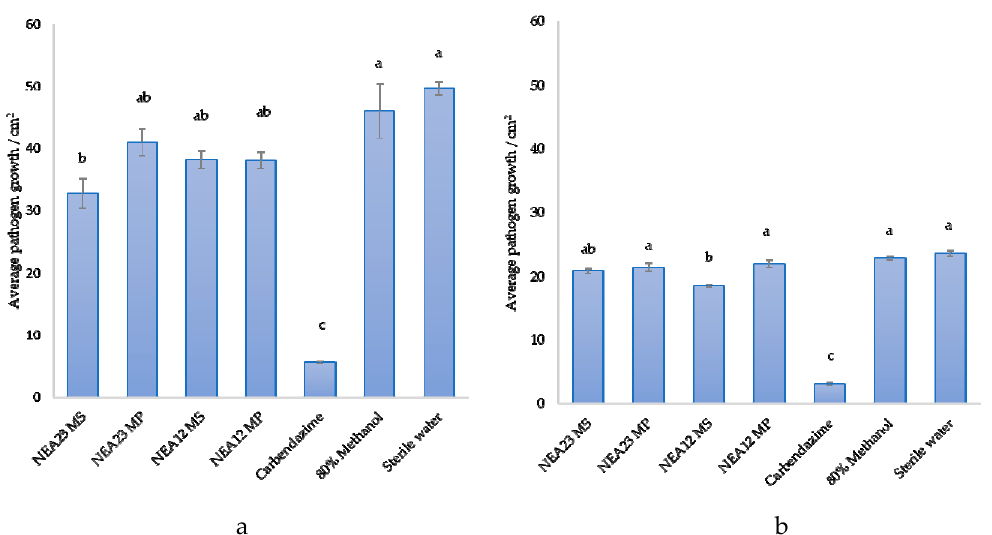
Figure 4. Pathogen growth inhibition by crude extracts from Epichloë spp. endophyte strains NEA12 and NEA23. From left to right: NEA23 MS, NEA23 MP, NEA12 MS, NEA12 MP, carbendazime (1 mg/mL), 80% methanol, and water against ( a ) Ceratobasidium sp; ( b ) Fusarium sp. Image analysis measured growth area (cm 2 ) of the pathogen in the agar well diffusion assay. All data are mean ± standard error, n = 5. Means that do not share a letter are significantly different. Significance was determined by one-way ANOVA and Tukey post-hoc test for pairwise comparison; p < 0.01 indicates significant inhibition.